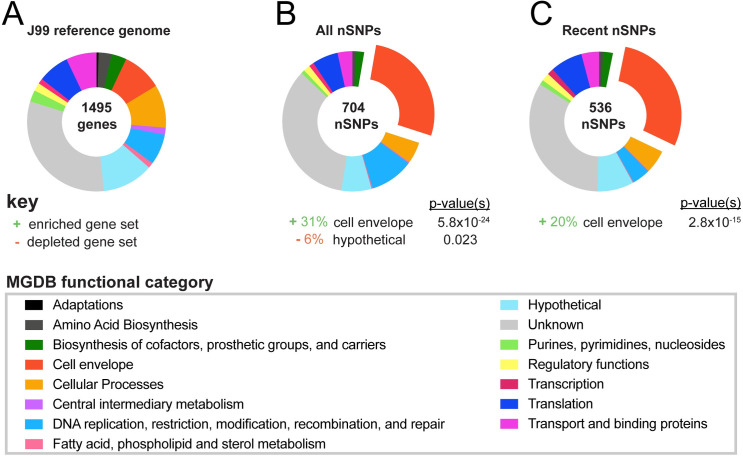
Cell envelope genes accumulate genetic variation during chronic infection.(A) Proportion of genes within the reference genome (J99) comprising each of 14 functional classes identified in the Microbial Genome Database and color-coded according to key [50]. Percentage of genes with unknown function are labeled in gray. (B-C) Proportion of nSNPs from (B) the entire dataset (all nSNPs) and (C) from the subset unique to recent isolates (recent nSNPs) that fall within each functional class. Categories with statistically significant enrichment or depletion are listed below each chart with associated percentages and p-values (<0.03). Fisher’s exact tests were used to determine significance and corrected for multiple testing using Benjamini and Hochberg false discovery rate methods.